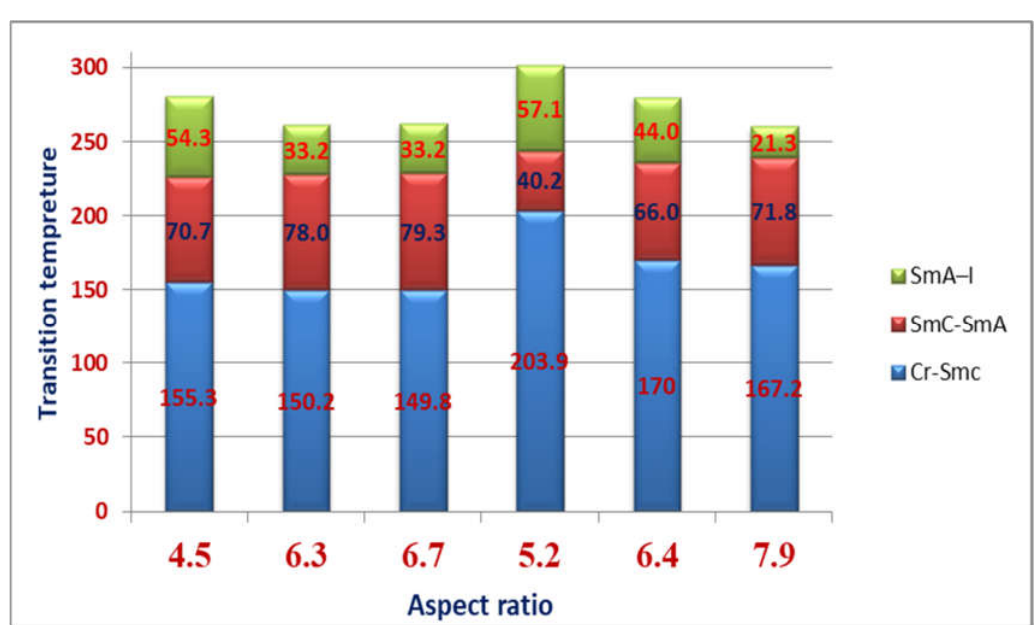
Figure 6. Dependence of the aspect ratio of the prepared compounds with the transition temperature.